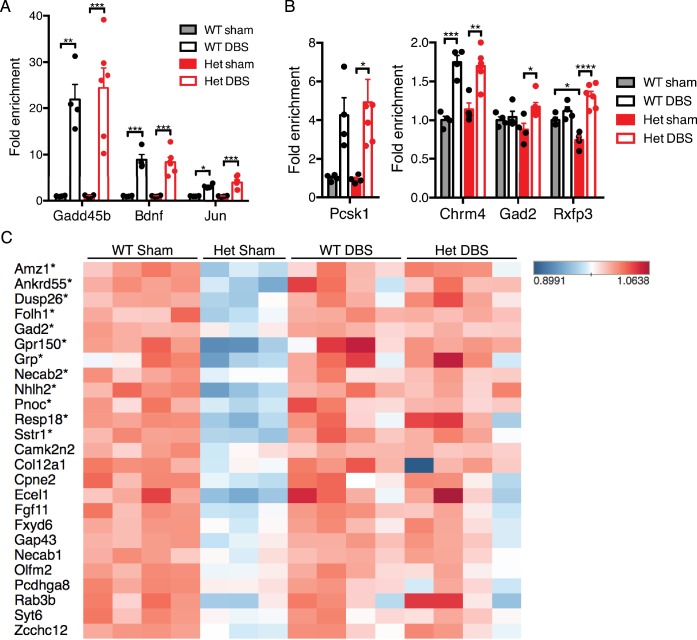
Forniceal DBS induces similar acute gene expression changes in Mecp2-heterozygous (Het) mice and reveals a trend for sustained gene expression rescue following chronic DBS.(A) and (B) RT-qPCR data from 8.5-week-old female samples following acute DBS (45 min of DBS; n = 4 WT sham, 4 WT DBS, 4 Het sham, and 6 Het DBS; significance determined using an two-way ANOVA with Holm-Sidak multiple comparisons test; error bars: SEM; *p<0.05; **p<0.01; ***p<0.001; ****p<0.0001). (C) Heat map of RNA-Sequencing data from 13.5-week-old WT and Het female chronic forniceal DBS samples showing a subset of the protein coding genes that are downregulated by at least 20% (padj <0.05) in Het sham samples. Genes with an asterisk (*) are those that are significantly increased (fold-change >15%; FDR < 0.05) in the Het samples that received chronic DBS. All quantified gene expression data from chronic DBS and sham treated female mice can be found in Figure 6—source data 1. Figure 6—figure supplement 1 shows a heat map of all genes that are either down- or upregulated at least 20% (FDR < 0.05) in Het sham mice.10.7554/eLife.34031.023Figure 6—source data 1.Quantified gene expression data from chronic forniceal DBS or sham treated wild-type and Mecp2-heterozygous mice.